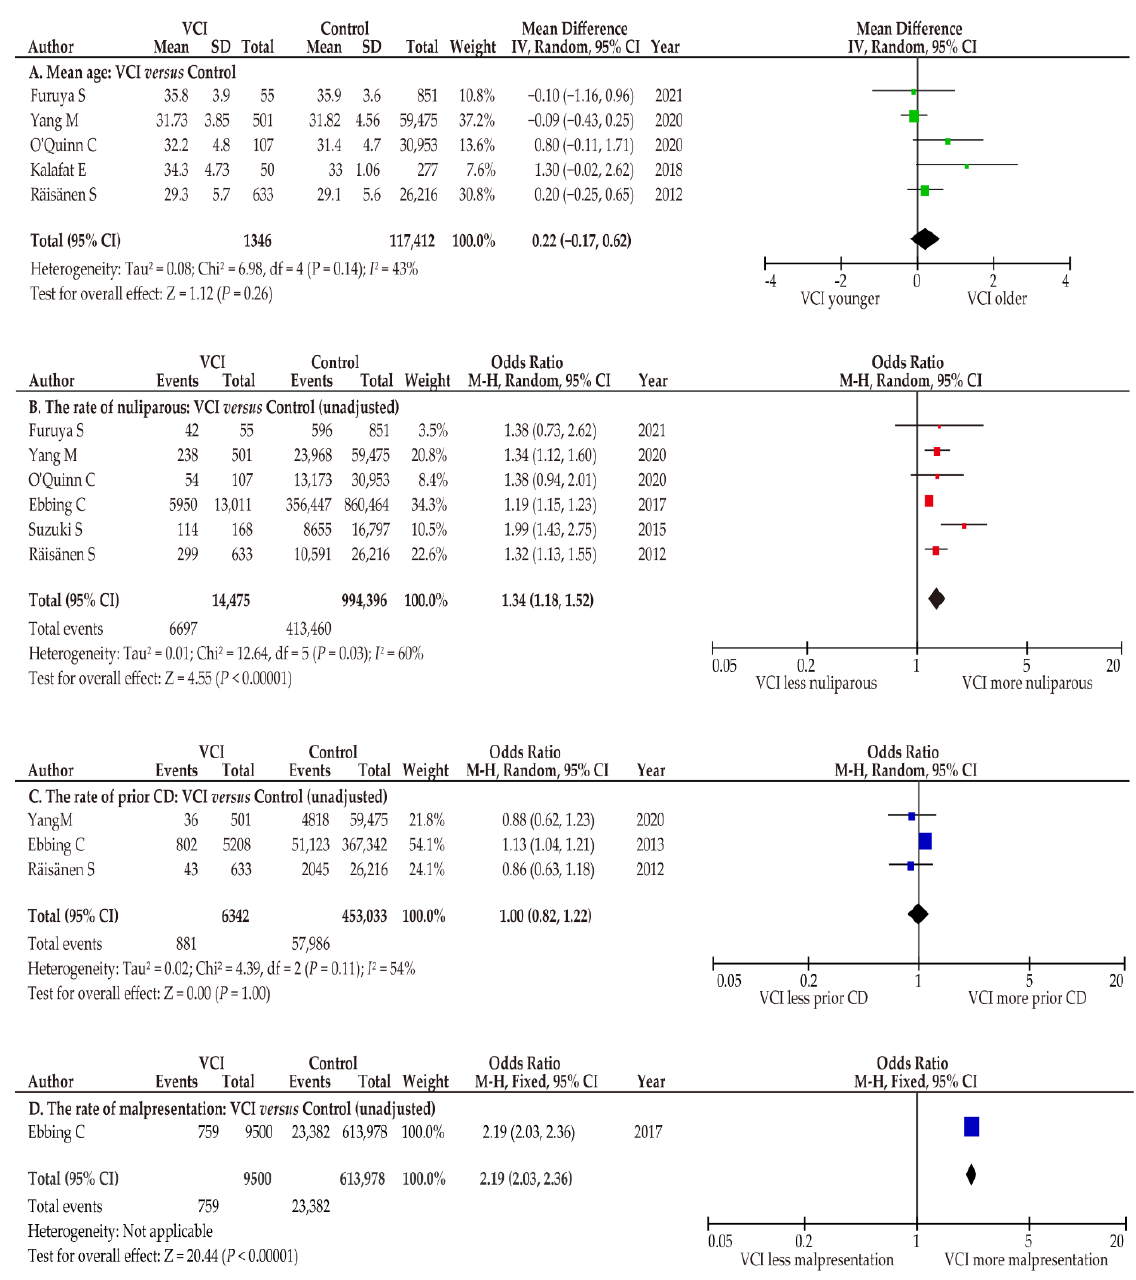
Figure 6. Differences in patient characteristics between women with and without VCI. Pooled ORs were calculated using RevMan version 5.4.1. (Cochrane Collaboration, Copenhagen, Denmark). Thus, some values may be slightly different from their original state. Because of moderate heterogeneity ( A , I 2 = 43%; C , I 2 = 54%) and substantial heterogeneity ( B , I 2 = 60%), random-effect analyses were applied. ( A ) Mean age; ( B ) rate of nulliparity; ( C ) rate of prior CD; and ( D ) rate of fetal malpresentation. Abbreviations: VCI, velamentous cord insertion; CD, cesarean delivery; OR,